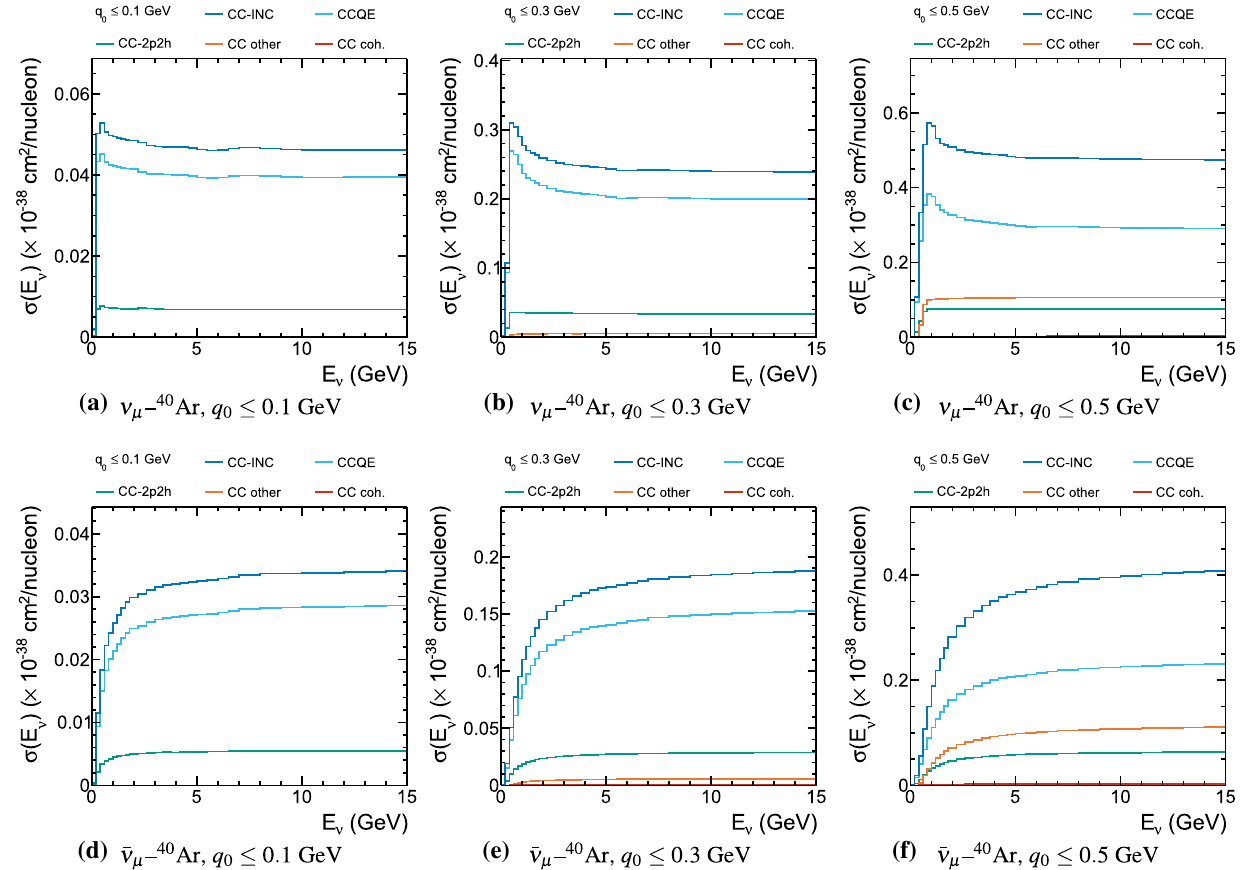
Fig. 1 Contributions to the GENIE 10a charged-current cross section with q 0 ≤ 0.1, 0.3 and 0.5 GeV as a function of E true ν , for both ν μ – 40 Ar and ¯ ν μ – 40 Ar, generated with a flat neutrino flux. Contributions from separate interaction channels are also shown